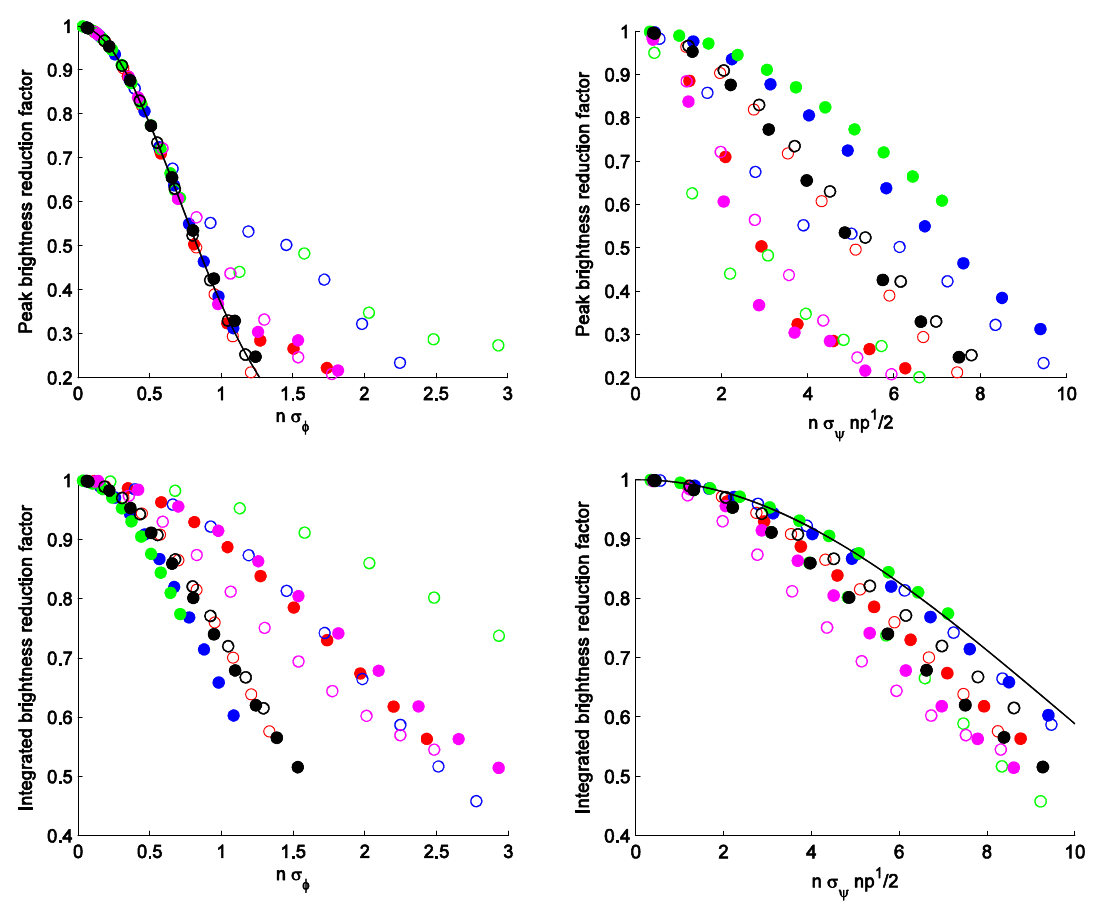
FIG. 16. Reduction factors in single-electron peak (upper plots) and integrated (lower plots) brightness, as functions of rms phase error (left-hand plots) and rms local phase error (right-hand plots) in radians, for the ten devices of Table I with corresponding symbols. Solid lines: upper-left plot—Eq. (1); lower-right plot—Eq. (6).